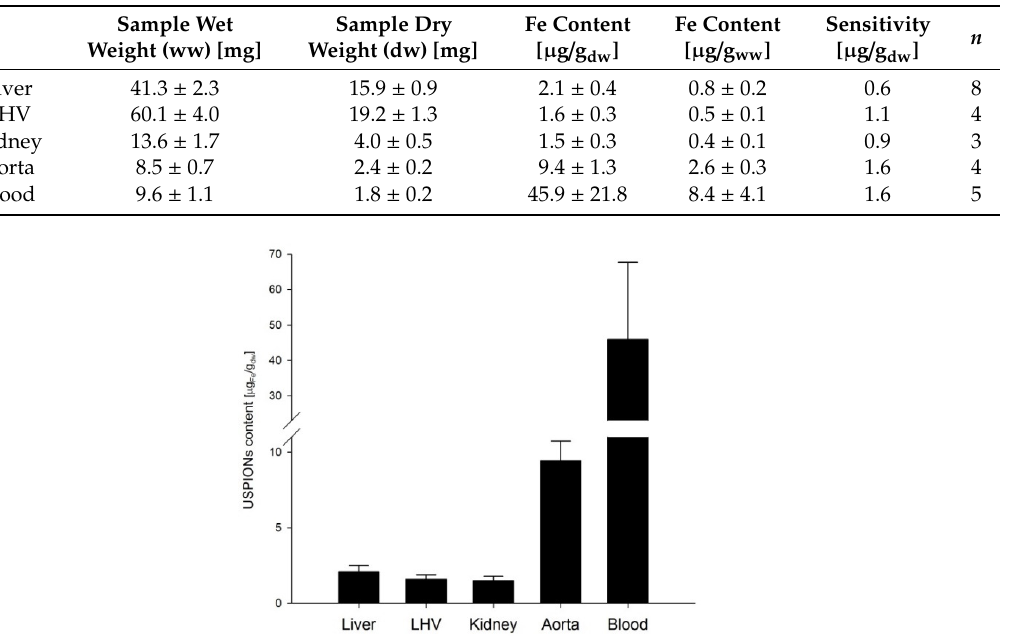
Figure 17. Mean USPION-originated iron content determined in the tissues of liver, left heart ventricle (LHV), kidney, aorta and whole arterial blood. Results are presented as mean ± SEM.